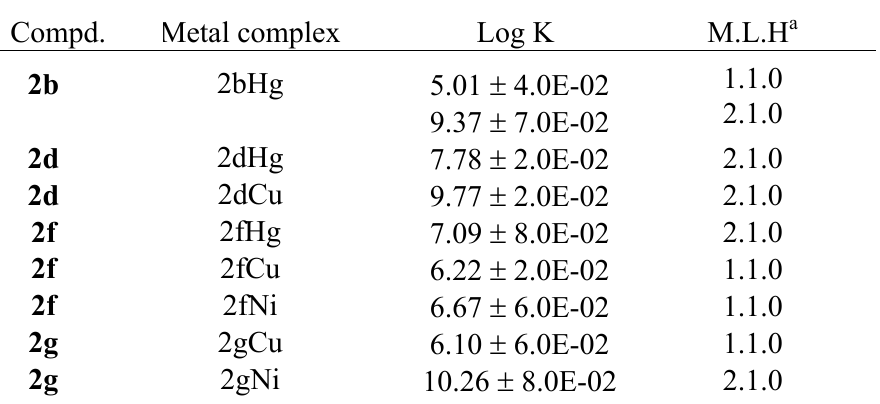
Table 3. Complexation constants for alanine derivatives 2b - d and 2f-g with Cu(II), Ni(II) and Hg(II)